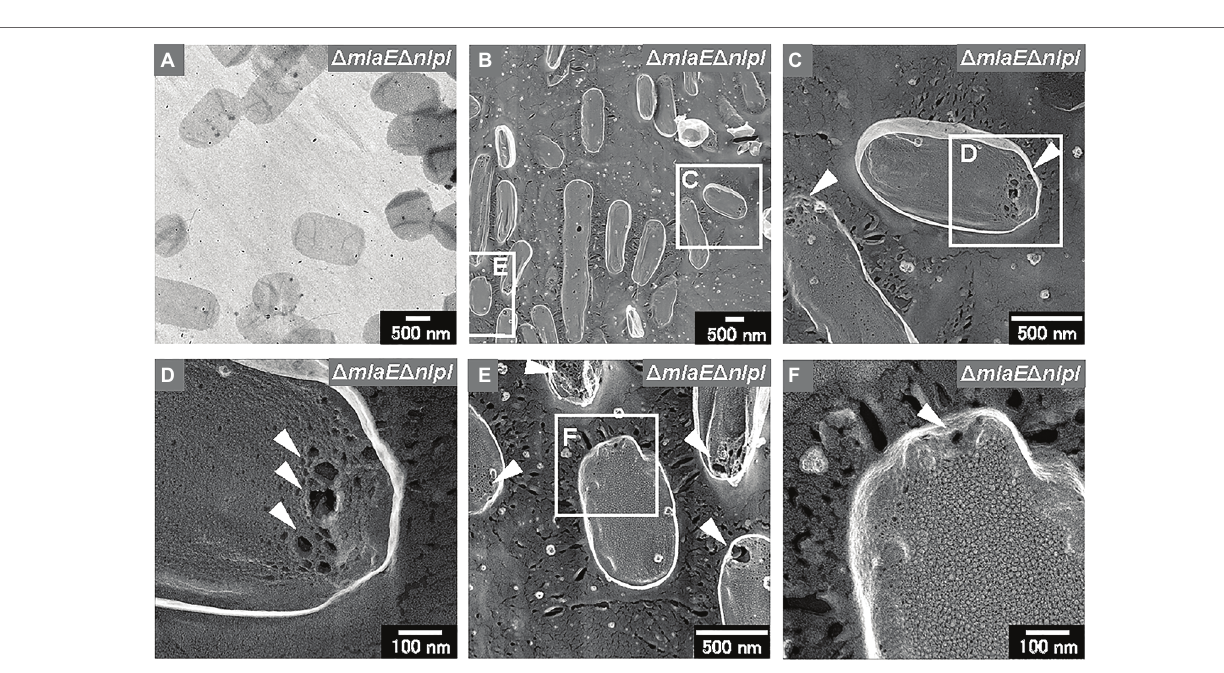
FIGURE 8 | Sacculi of the Δ mlaE Δ nlpI cells. (A) TEM image of sacculi stained with uranyl acetate. (B–F) Surface structures of the sacculi were visualized via QFDE- EM. The holes on the peptidoglycan (PG) surface are marked by